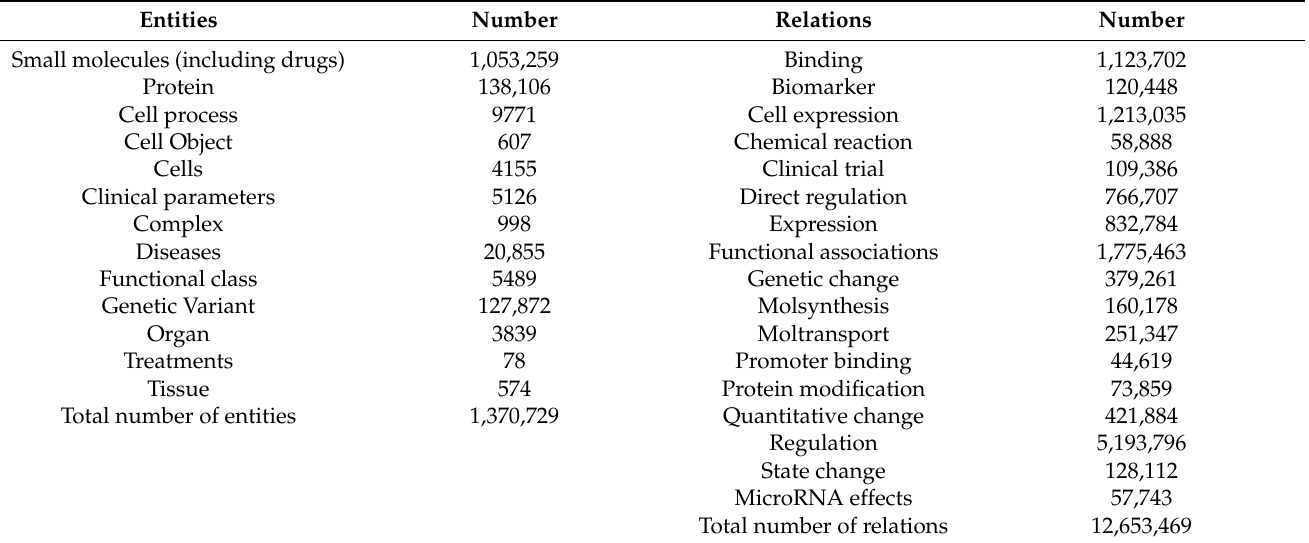
Statistics of Mammalian + ChemEffect + DiseaseFx database used for literature mining in this